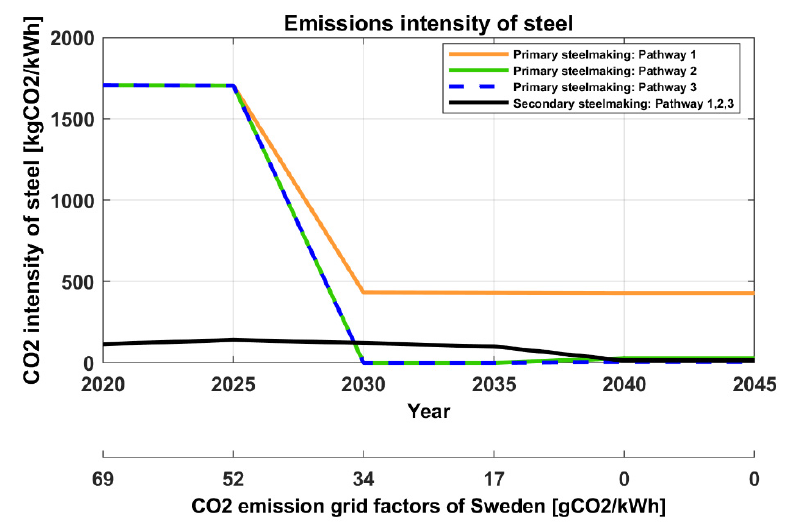
Figure 6. Development of CO 2 emission intensity of the steel production (primary and secondary steelmaking) for the three pathways.